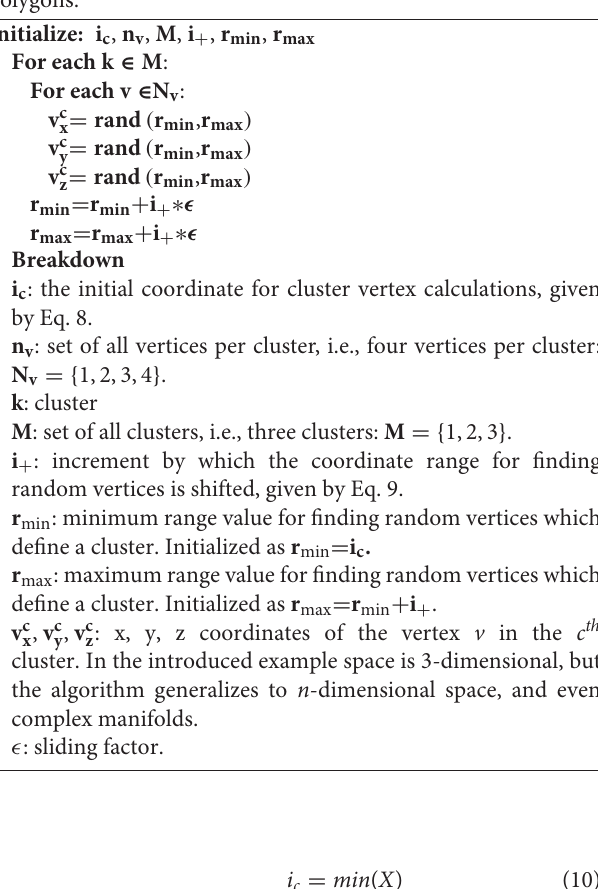
Algorithm 1 Cluster definition based on n -dimensional